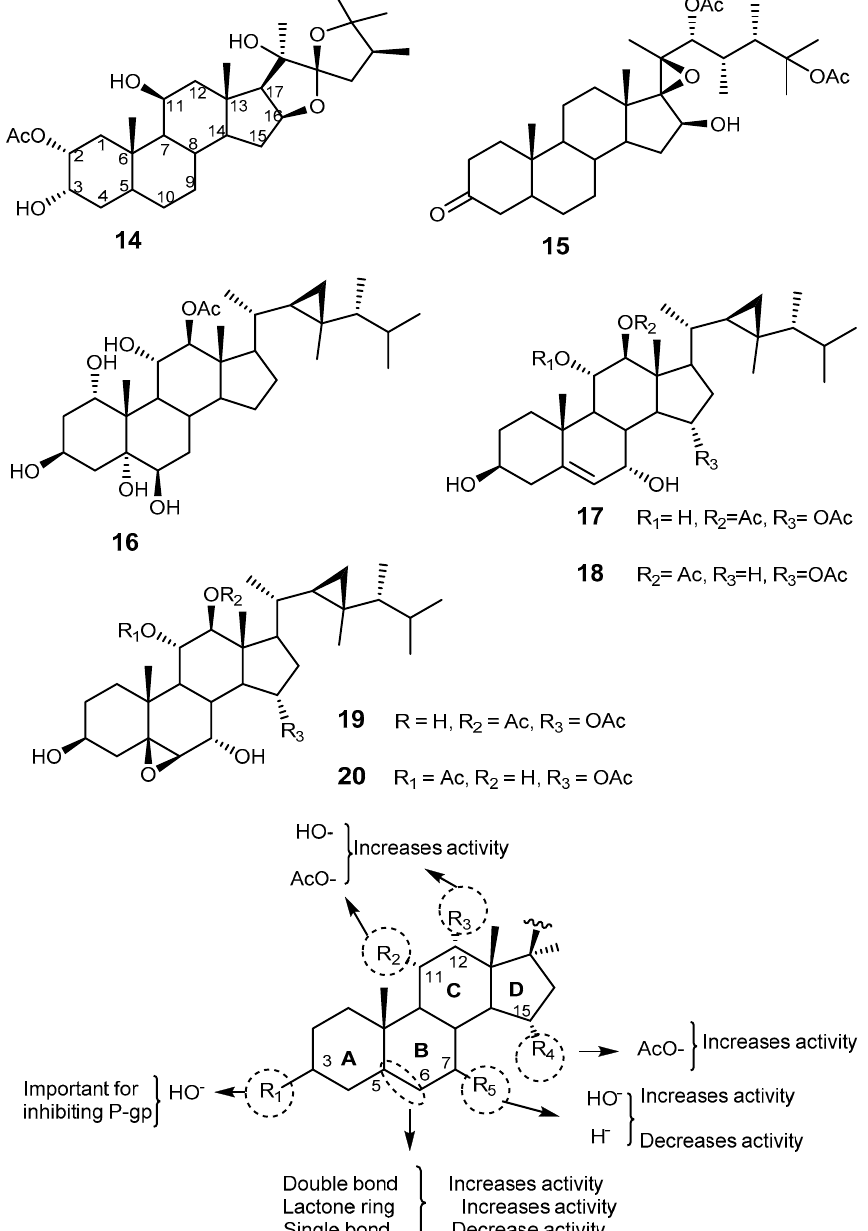
Figure 4. The structures of polyoxygenated steroids 14 – 20 , and SAR for polyoxygenated steroids with antitumor activity in overexpressing P-gp cells.